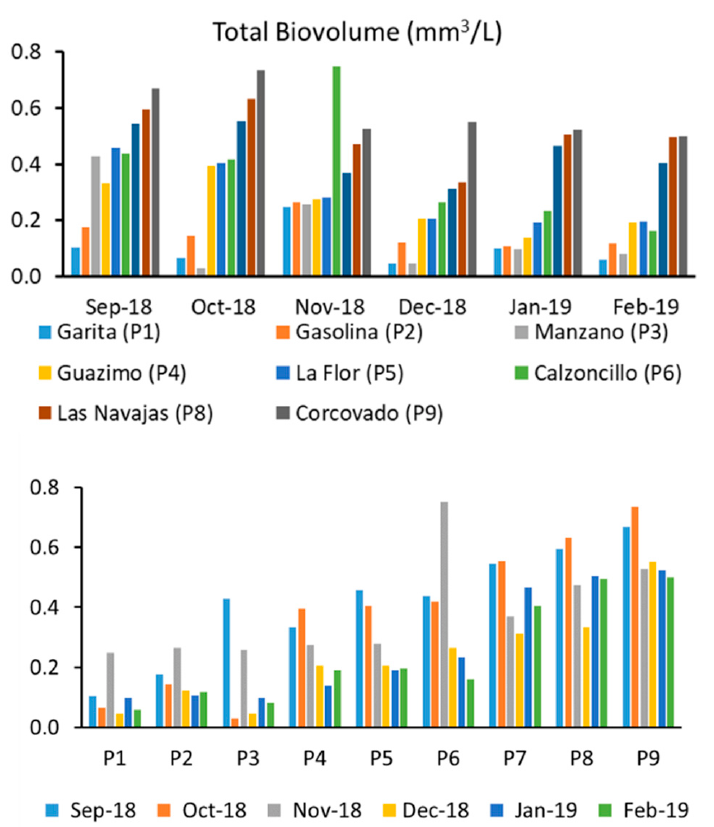
Figure 9. Biovolume of MIC (microalgae and cyanobacteria) observed in the nine sites of the Estero Salinas Grandes over the sampling period and temporal dynamics of biovolume in each site. The main algal groups that made up the MIC biovolume in ESG were Chlorophyta and Bacillariophyta or Diatoms (Table S3). The presence of Dinophytes ( Tripos fusus , less than 1 ind/mL) was only detected in February, and no cyanobacteria or Euglenophytes were found. The average Chlorophyta density of the locations in each month barely exceeded 600 ind/mL, decreasing over the time period (Table S3). In total, 12 populations of 12 genera of Chlorophytes were found (Table S5). The most notable were Dictyosphaerium, Coenocystis and Monoraphidium for their abundance and occurrence (Figure 10). Diatoms do not show any trend over time (Table S3). Their density ranged from 50 ± 40 ind/mL in December to 319 ± 263 ind/mL in November, with the maximum value (972 ind/mL) being observed at P6, an intermediate point of the course of the estuary. This is the group of algae with the greatest diversity, and populations of 24 genera were found (Table S5). Aulacoseira granulata , Nitzschia sinuata and Surirella were the most remarkable (Figure 10). The CCA allowed us to discriminate a spatio-temporal pattern of the most abundant populations (Figure 10) with three possible associations: one that appears in the rainy September, the month with the highest temperature but also lowest levels of salinity and nutrients, and two other associations opposed to each other; one more related to nutrients and sites located a long way from the sea, and the other one to the sites closest to the sea and related to salinity (Figure